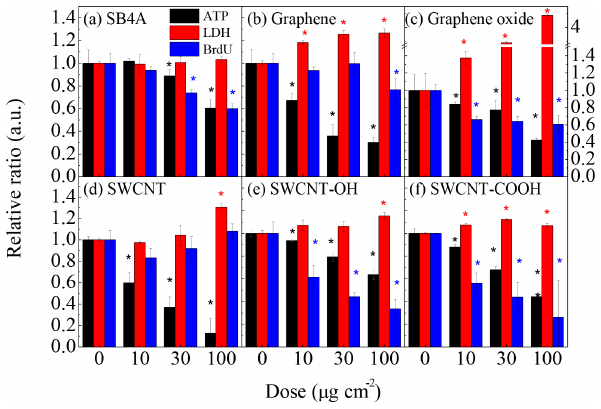
Figure 2. Cytotoxicity of (a) SB4A, (b) graphene, (c) graphene ox- ide, (d) SWCNT, (e) SWCNT-OH and (f) SWCNT-COOH toward the murine J774 cell line. The stars mean the difference is significant at 0.05 level for a certain dose of carbon nanomaterials compared to the corresponding blank